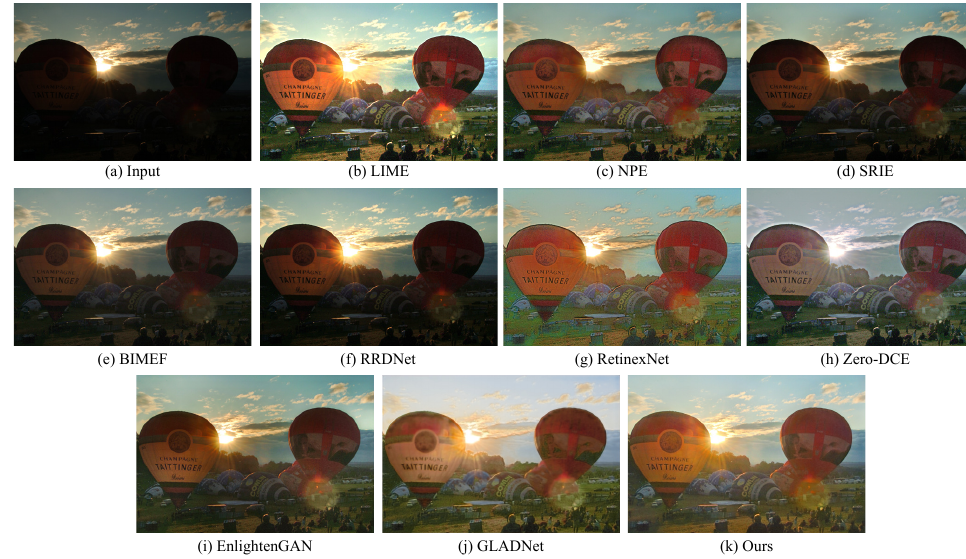
Figure 8. Visual comparisons of different methods on a real image from MEF dataset.